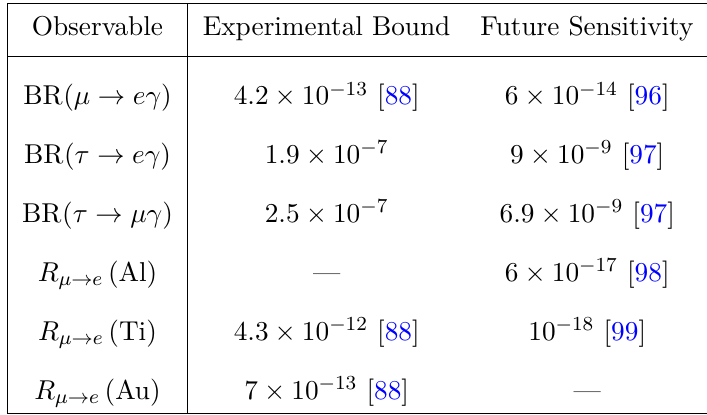
Table 4 . Experimental determinations and future sensitivities, at 90% C.L., for a selected list of lepton flavour violating processes. “—” indicates that no bound is expected. The values of BR( τ → eγ ) and BR( τ → µγ ) have been obtained according to the definition in eq. (3.22), with experimental data from ref. [88].